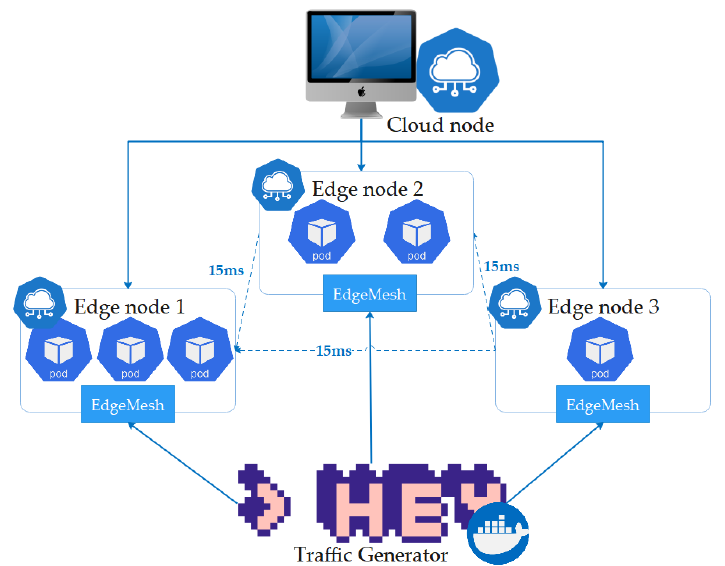
Figure 4. Experimental setup.